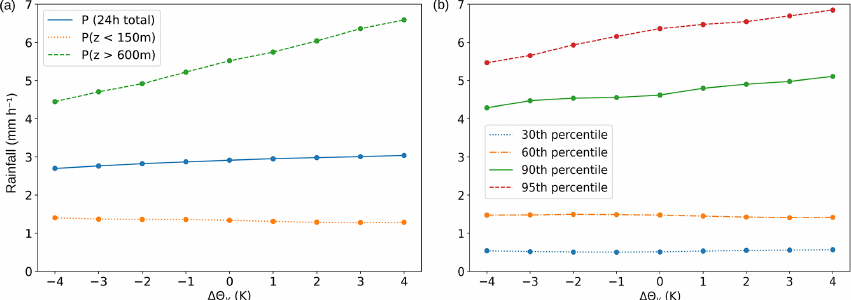
Figure 5. (a) Average 24h rainfall rate evaluated inside LAKEDISTR ( p in solid blue, p ridge in dashed green, p low in dotted orange) for the PB- T simulations with − 4K ≤ (cid:49)(cid:50) v ≤ + 4K. (b) The 30th, 60th, 90th and 95th percentile for the PB- T